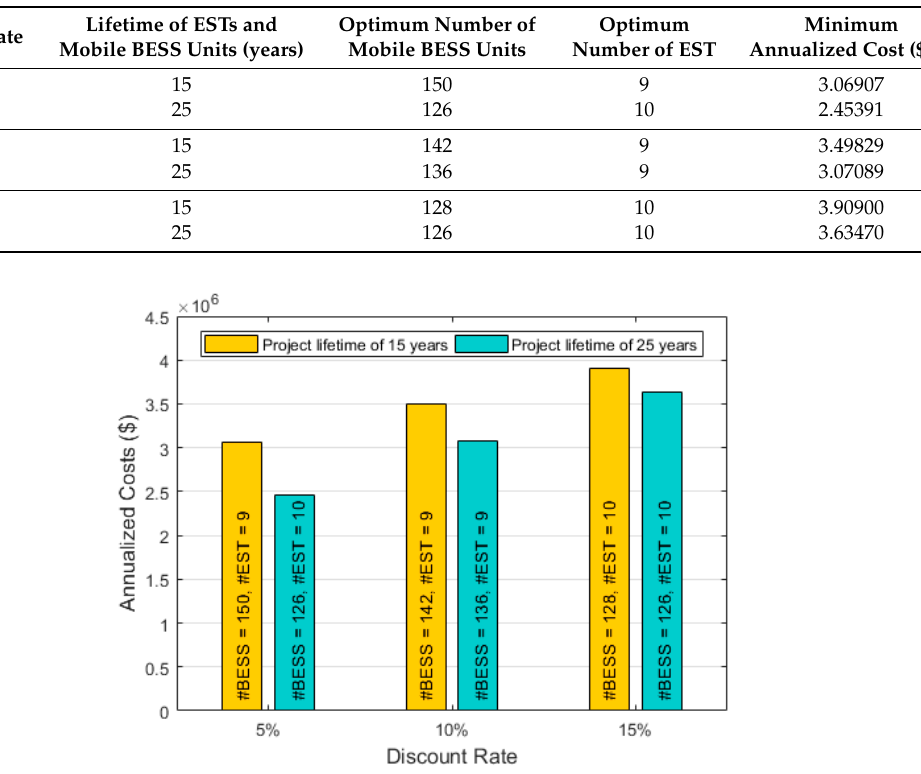
Figure 8. The results of the optimization process under three diverse scenarios of economic discount rates and two cases for the project’s lifetime; the anticipated lifetime of both ESTs and mobile BESS units. In this study, the cost of each EST is $150 k while the cost of each mobile BESS unit is $100 k.